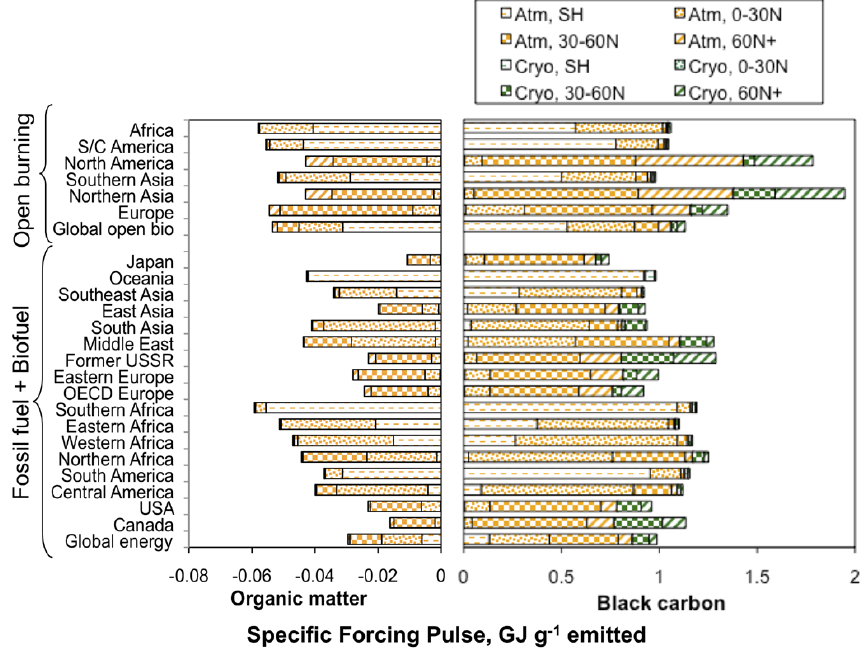
Fig. 4. Specific Forcing Pulse for BC and OM aerosol emitted from 23 region-source combinations, estimated with a single model (NCAR CCSM). SFP includes direct atmospheric and cryosphere impacts only. Note the difference in scale between the positive values for black carbon and negative values for organic matter. The single-model values presented in this figure are adjusted to reflect model ensembles